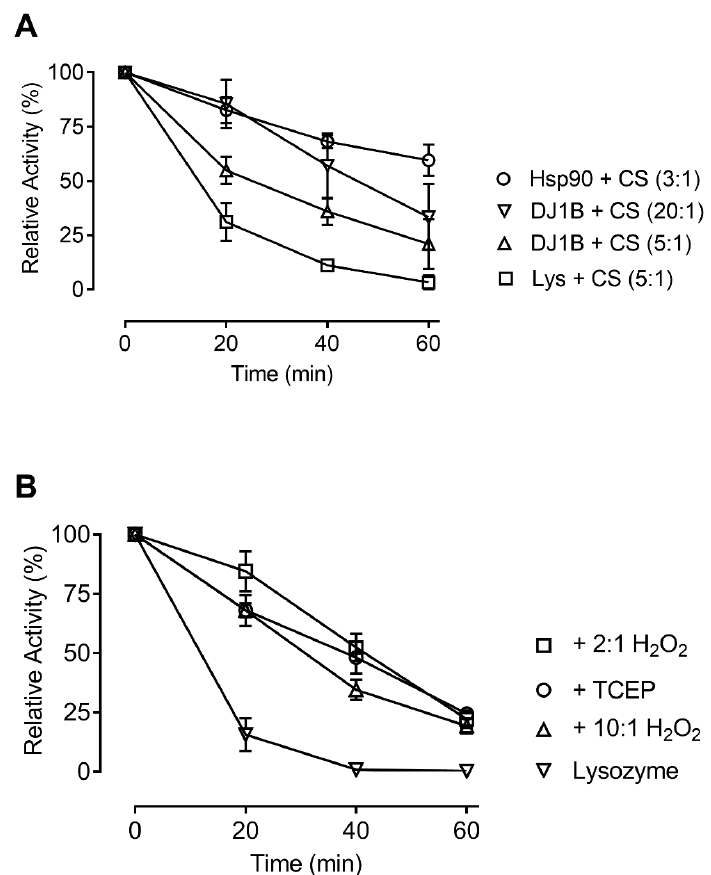
Figure 4. Suppression of thermal inactivation of citrate synthase (CS) by AtDJ-1B is independent of the oxidation state of AtDJ-1B. ( A ) At 44 °C, CS was incubated with 5-fold molar excess of lysozyme, 3-fold molar excess of Hsp90, 20- or 5-fold molar excess of DJ-1B at 44 °C, and activity measurements taken every 20 min for 1 h. ( B ) CS was incubated with 5-fold molar excess of lysozyme, or 20-fold molar excess of DJ-1B, either reduced with 5 mM TCEP, or oxidized with 10:1 or 2:1 molar excess of H 2 O 2 at 44 °C, and activity measurements taken every 20 min for 1 h. Given is relative activity as a percentage of the full enzymatic activity of CS, just prior to heat-block incubation. Each data point represents average ± SD for triplicates.